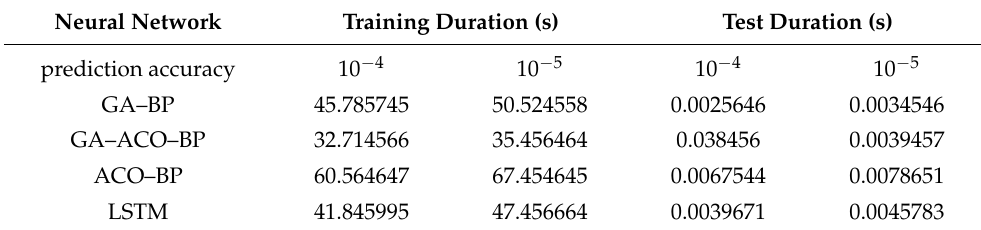
Table 5. Model efficiency comparison table (YueYang/curved channel).